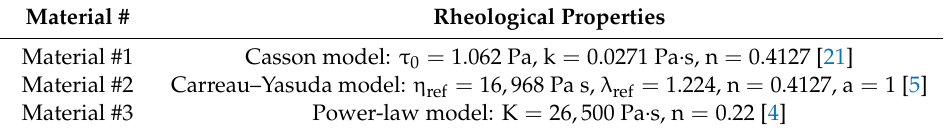
Table 3. Extrusion